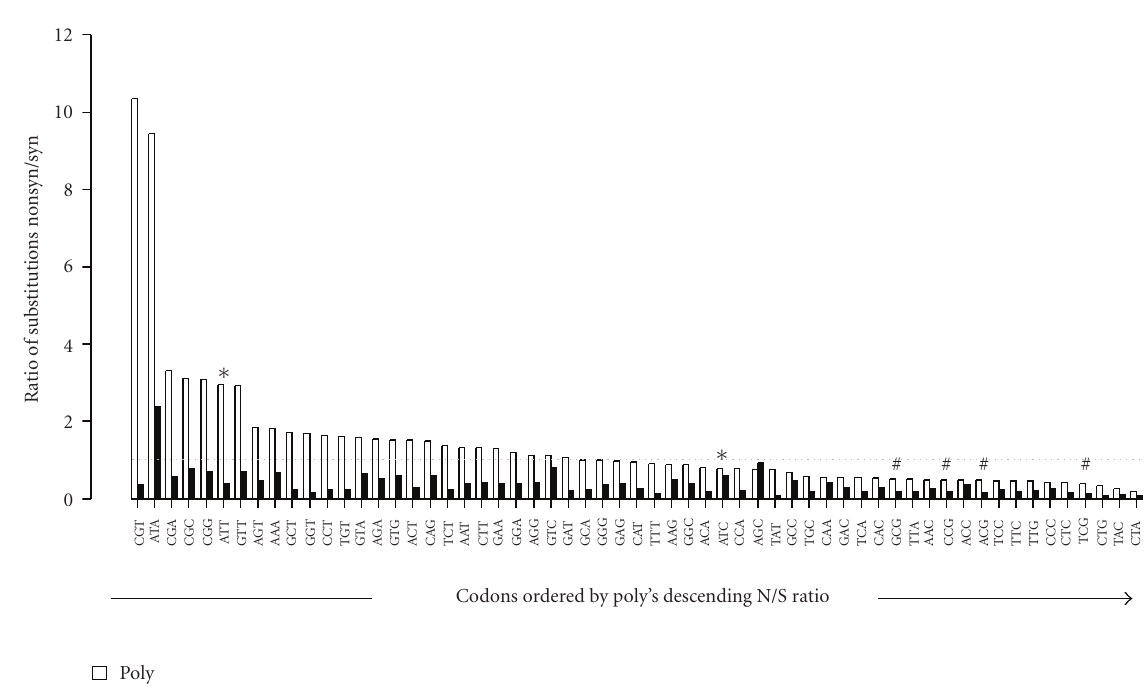
Figure 4: Nonsynonymous to synonymous substitutions (N/S) ratio calculated by the polymorphic and fixed nucleotide changes. Two codons (ATG and TGG) are not included because of their lack of synonymous substitutions. Symbol “#” indicates NCG codons. Codons are placed by the descending order of the polymorphism’s N/S